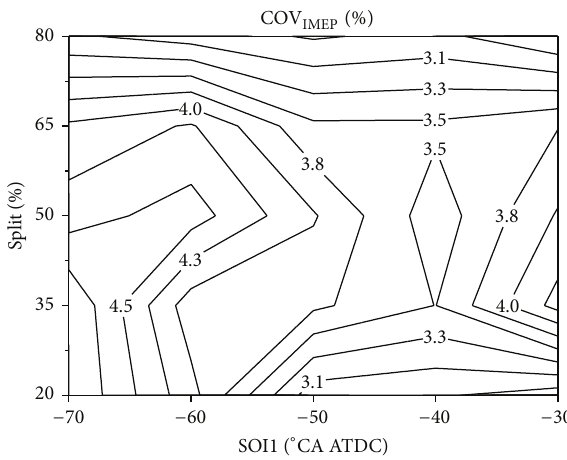
Figure 6: COV as a function of SOI1 and split IMEP